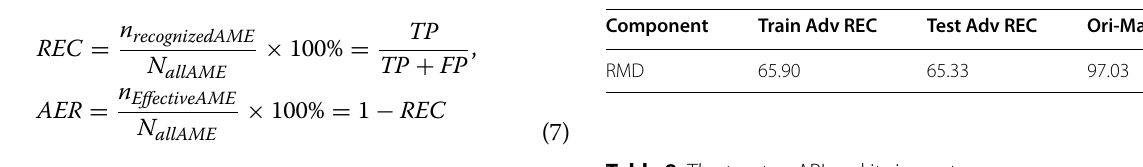
Table 7 The AME recognition Rate OF RMD